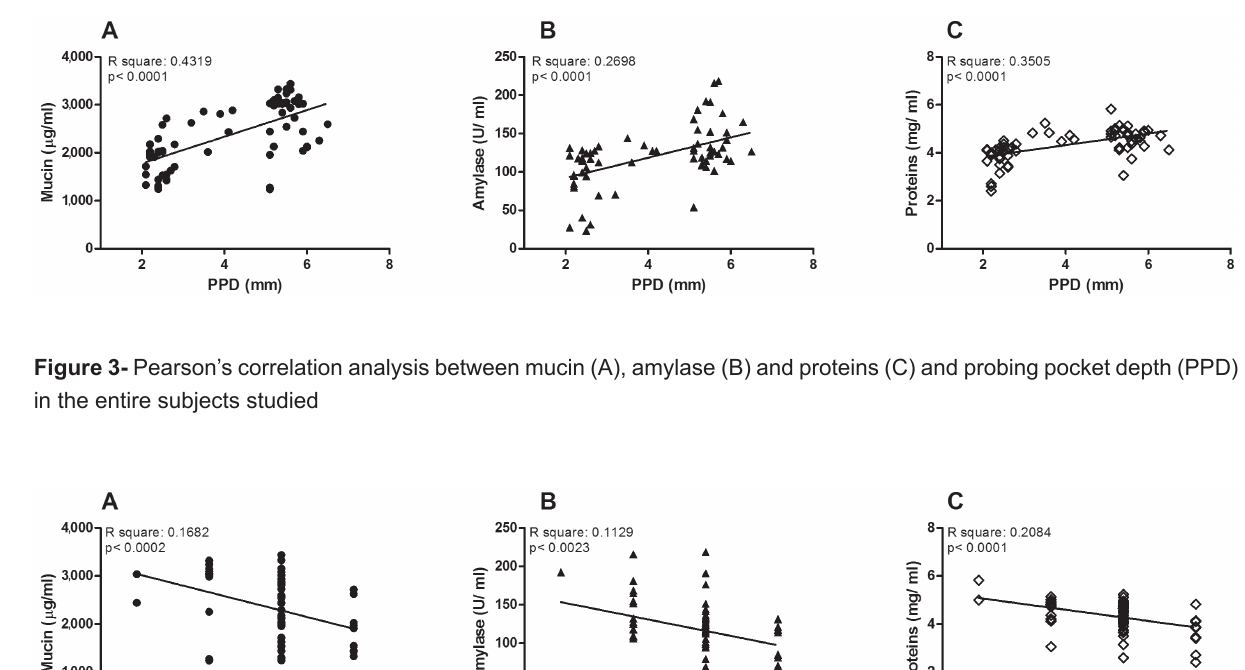
Figure 2- Pearson’s correlation analysis between mucin (A), amylase (B) and proteins (C) and clinical attachment level (CAL) in the entire subjects studied